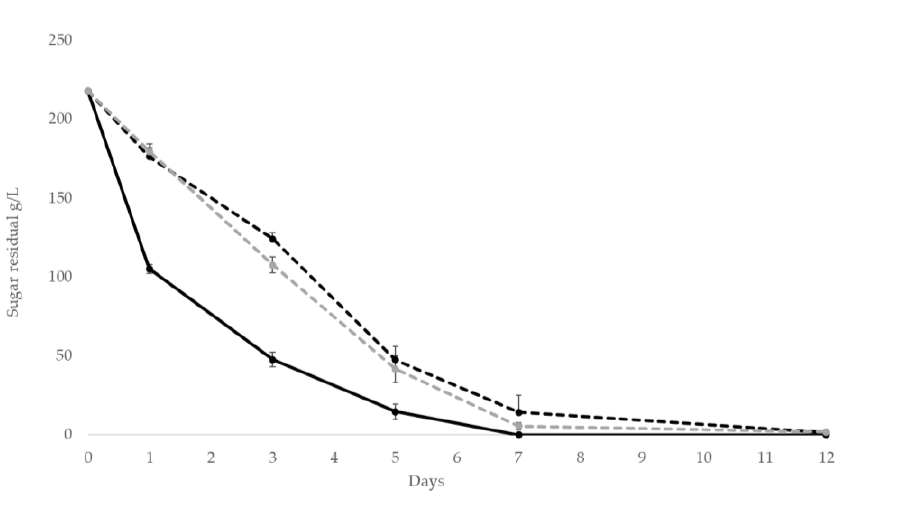
Figure 3. Sugar consumption kinetics in sequential fermentation trials S. bombicola / S. cerevisiae and control S. cerevisiae on natural grape juice (NGJ) in static and aeration condition. (